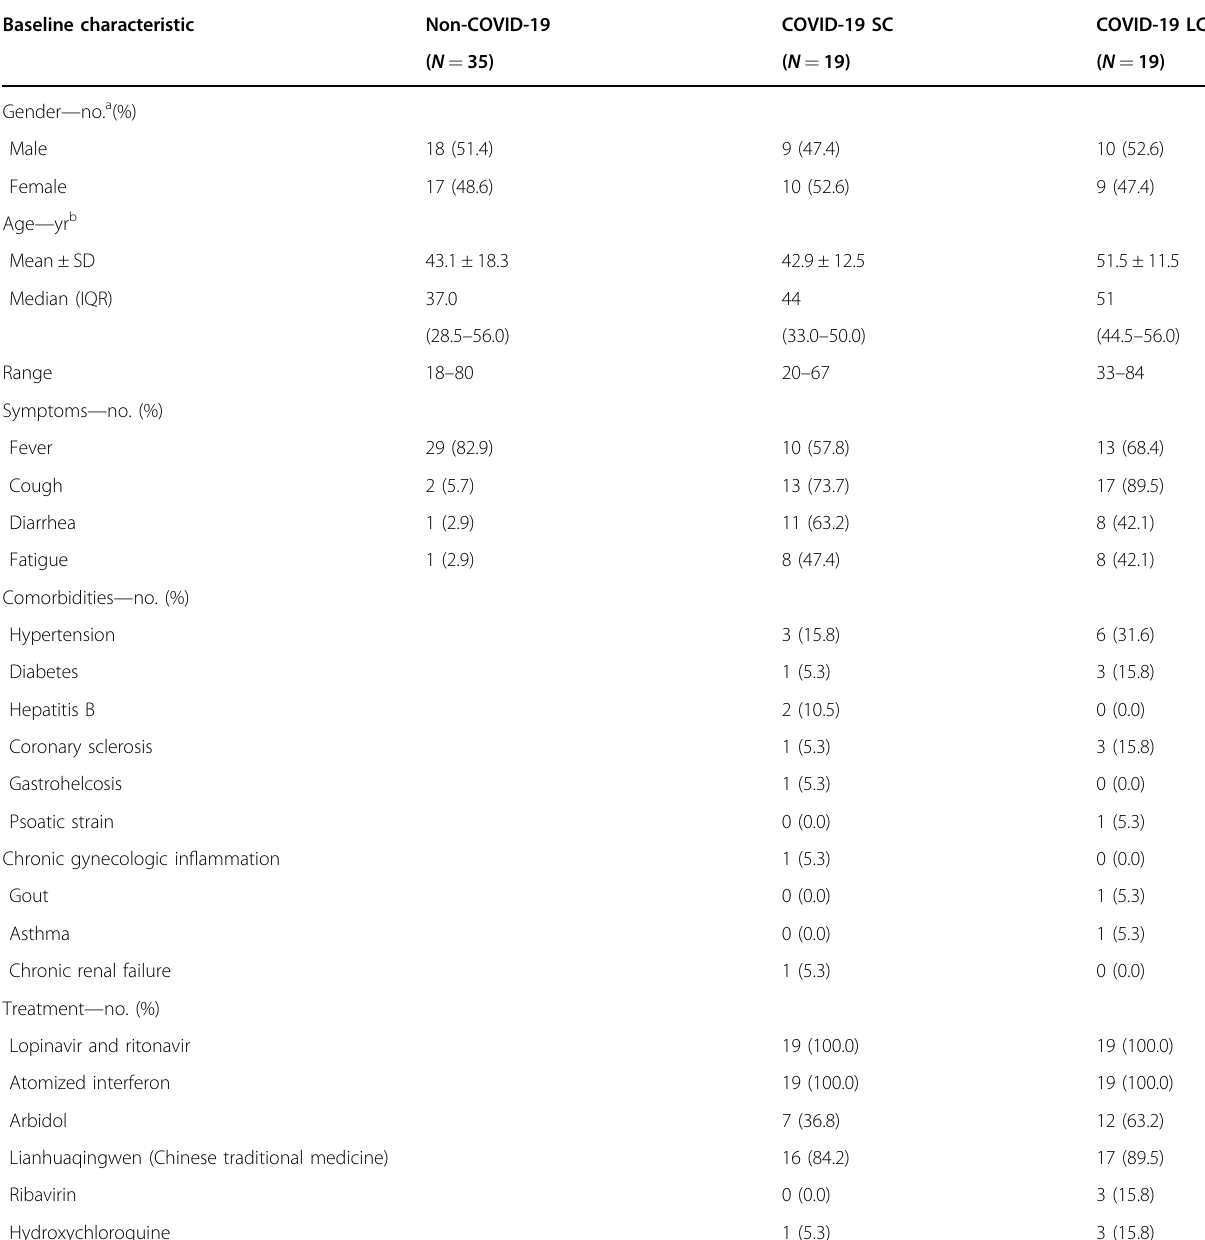
Table 1 Clinical characteristics of the studied